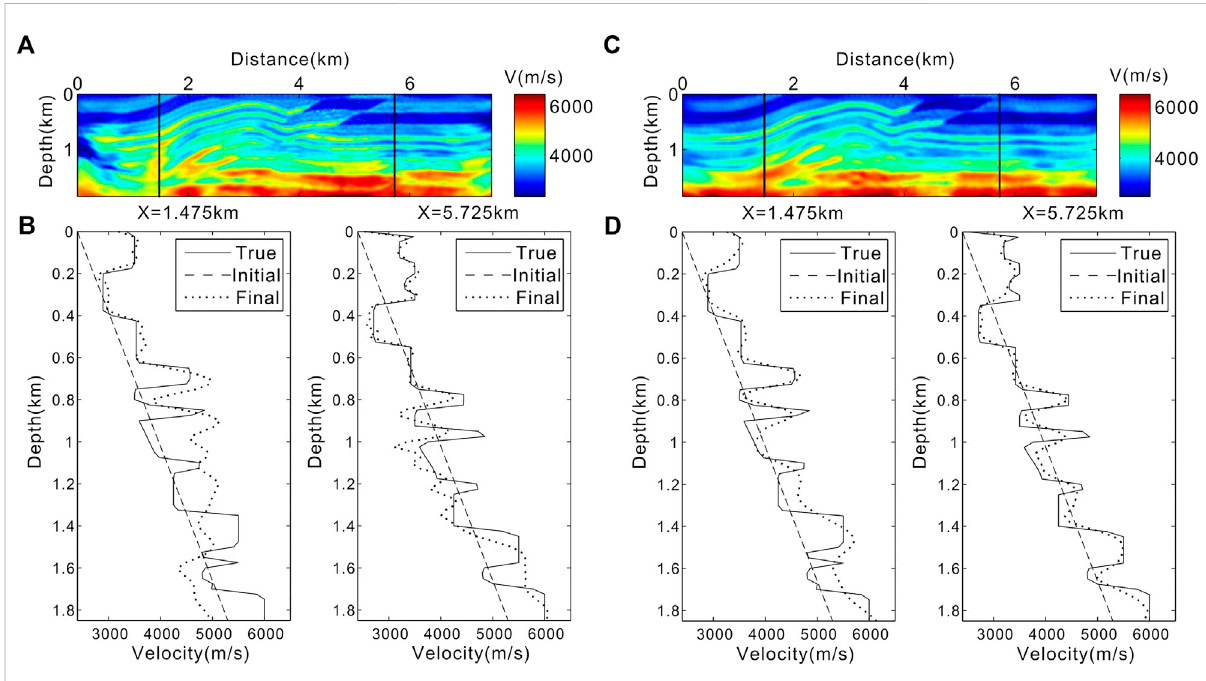
FIGURE 6 The results of frequency-domain FWI with noise-free data. (A) Reconstructed model using L-BFGS method. (B) Two vertical traces extracted from model (A) at x=1.475 and 5.725 km. (C) Reconstructed model using mL-BFGS method. (D) Two vertical traces extracted from model (C) at x=1.475 and 5.725 km. Solid line: the true velocity; dashed line: the initial velocity; dotted line: the reconstructed velocity.